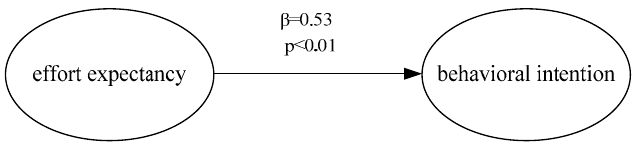
Figure 3. Direct effect of effort expectancy on behavioral intention.